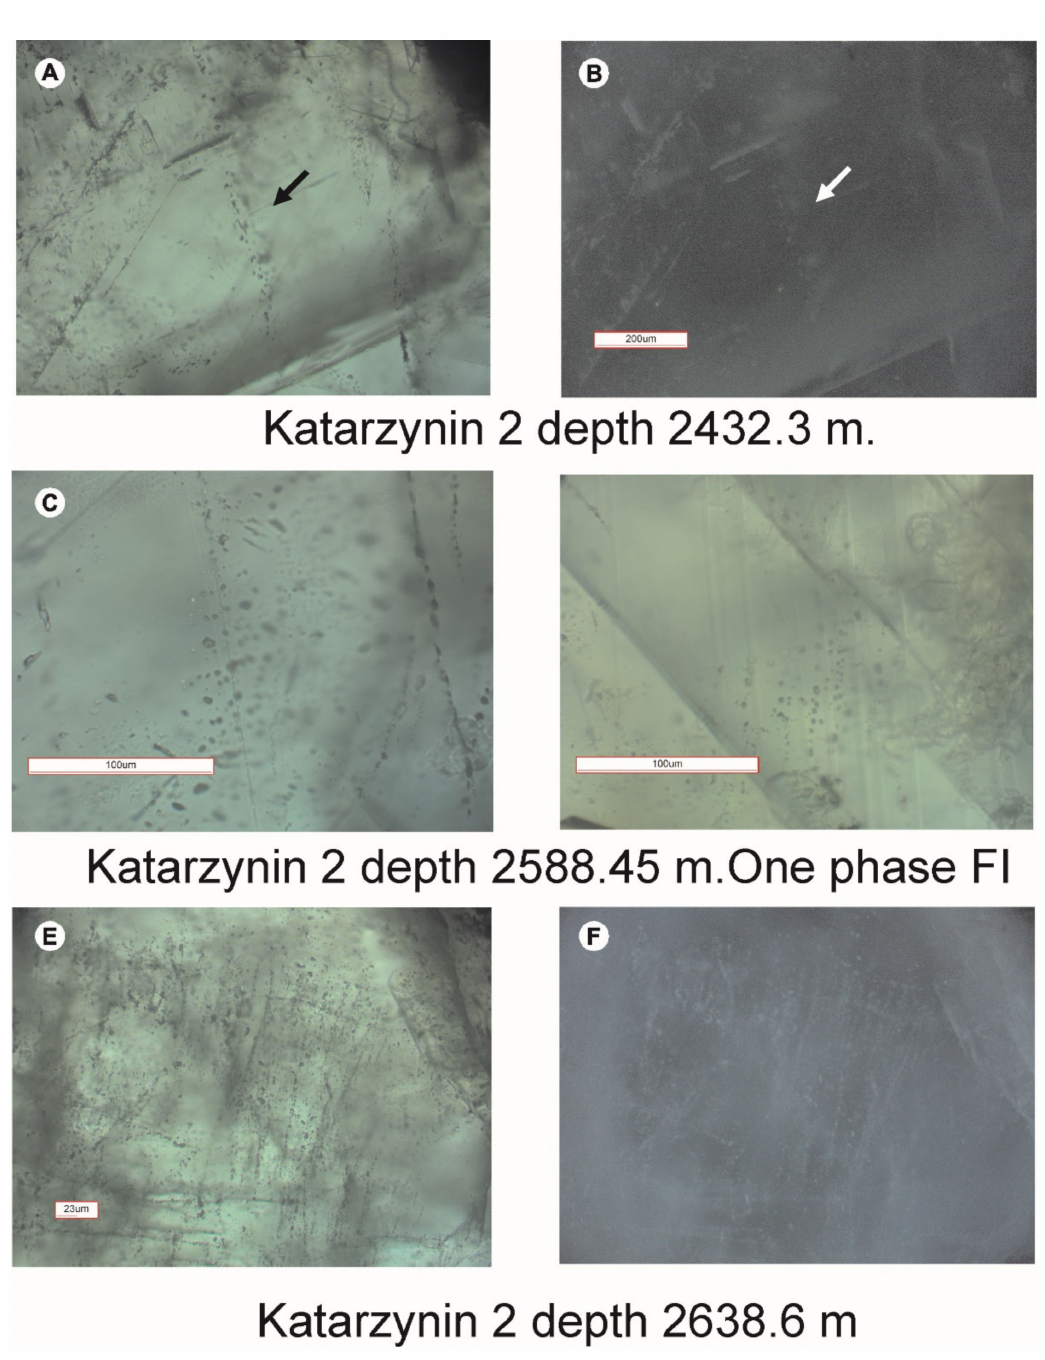
Figure 7. Fluid inclusions in carbonates in the Katarzynin 2 borehole section. Inclusions exhibit no fluorescence. Arrows point to the same objects as in photomicrographs. Polarized light, one polarizer ( A , C – E ); UV image ( B , F